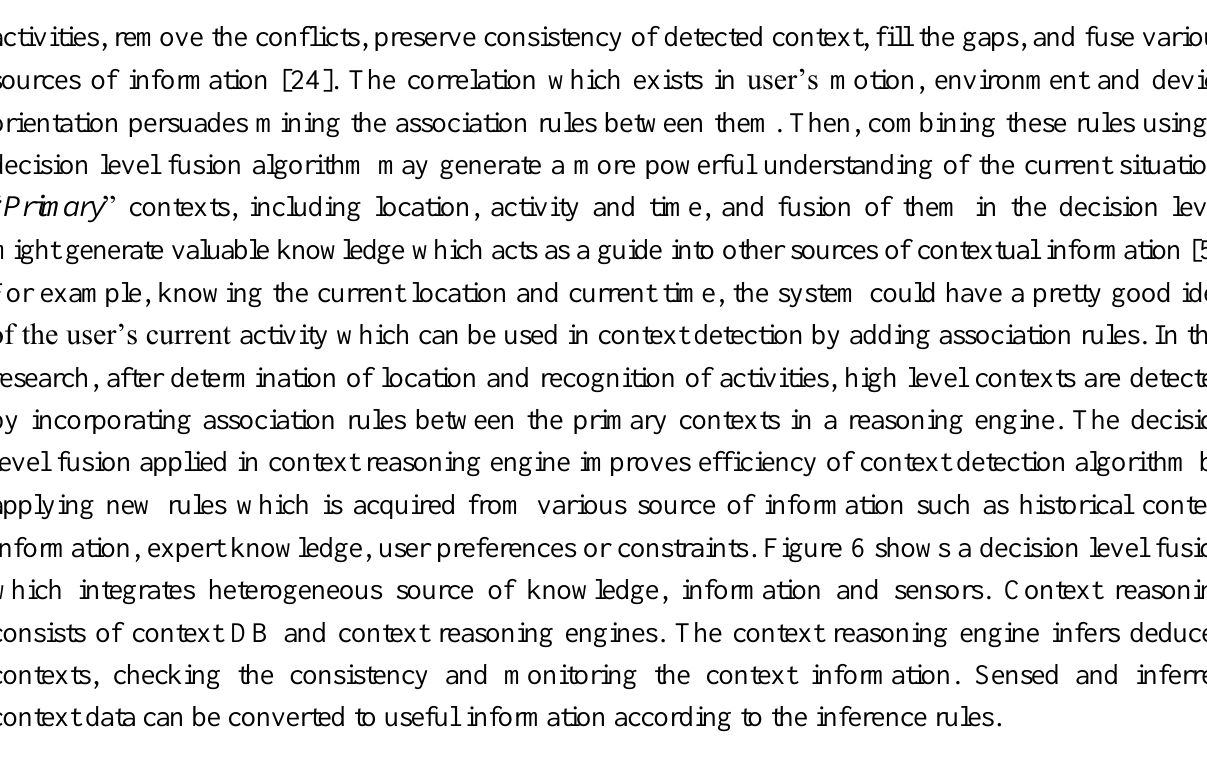
Figure 6. Context reasoning using decision level